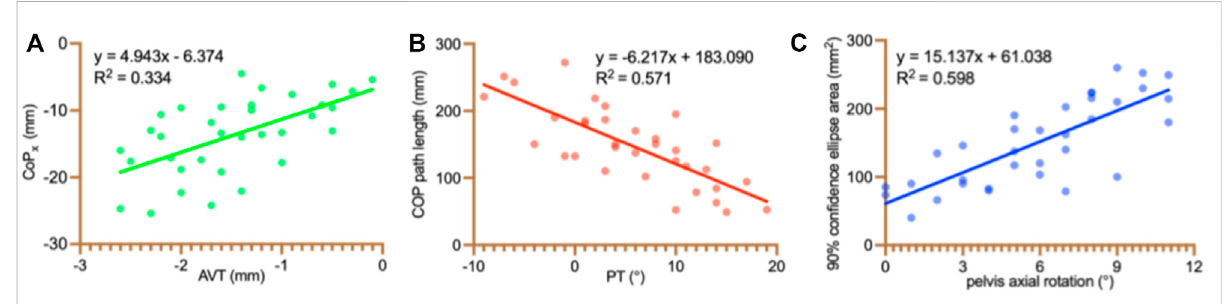
FIGURE 3 Statisticallysigni fi cantrelationshipsbetweenstaticbalanceandradiographicparameters.CoP:centerofpressure;CoPx:themeanmediolateral CoP position; AVT: apical vertebra translation; PT: Sagittal pelvic tilt.